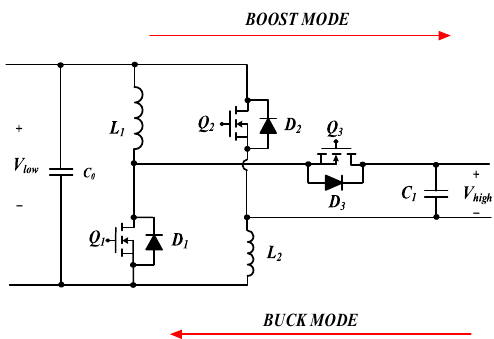
Figure 3. Proposed converter III (boost + buck-boost).